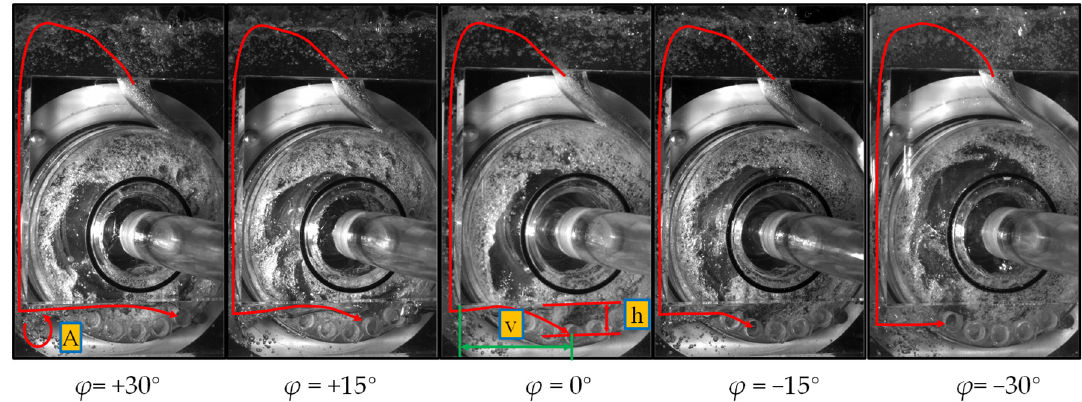
Figure 5. Flow pattern in pump with different reflux hole positions.